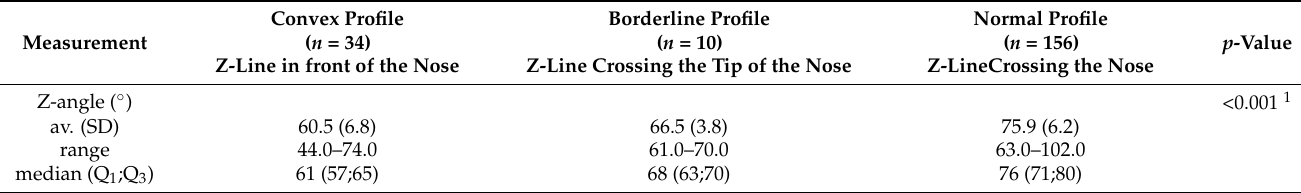
Table 6. The average values of the Z-angle with reference to the position of the Z-line.